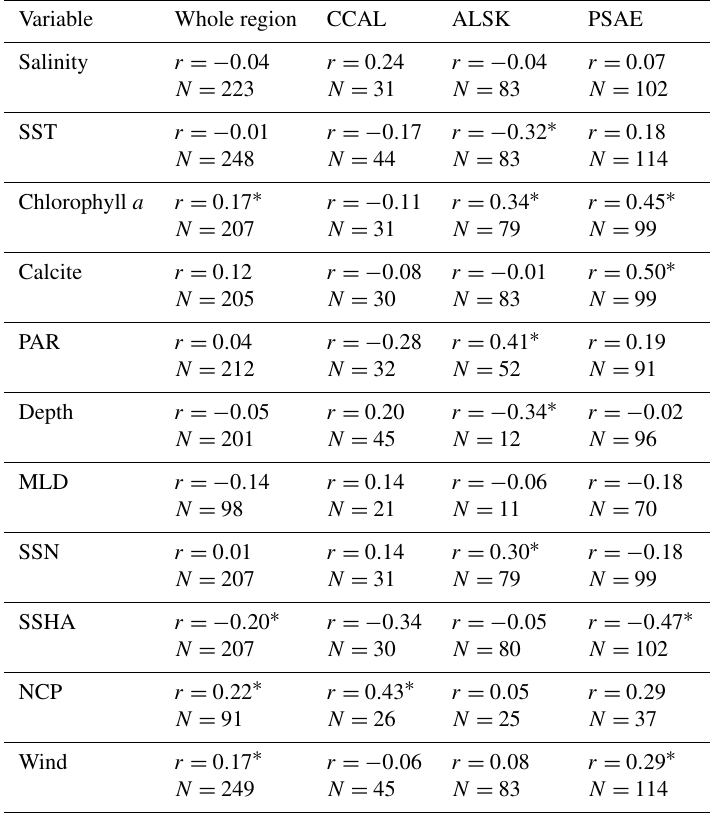
Table 4. Pearson’s correlation coefficients between DMS concentrations and other oceanographic variables binned to 1 ◦ spatial resolution. DMS data were derived from our combined PMEL and MIMS data set, variables are derived from in situ and satellite-based data. N represents the number of data pairs available for each correlation calculation ( ∗ indicates significance of p <0.05). Variable Whole region CCAL ALSK PSAE